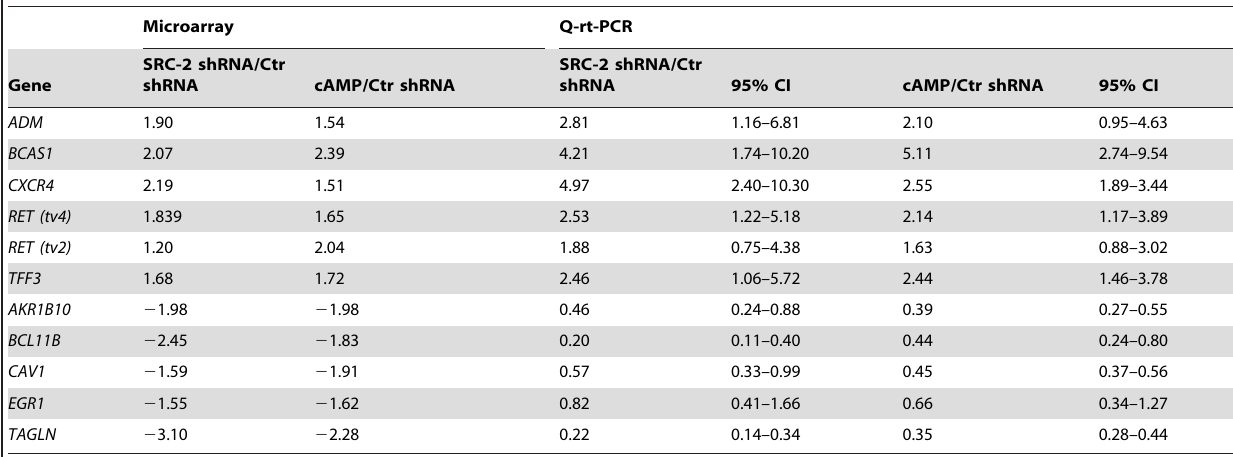
Table 3. Validation of selected genes by